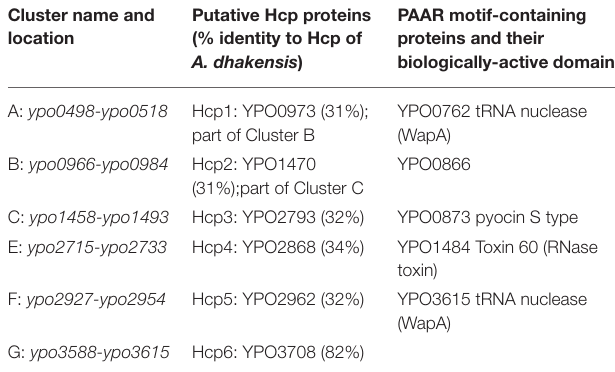
TABLE 1 | Putative T6SS loci, Hcp proteins, and PAAR motif-containing proteins identified in the Y. pestis